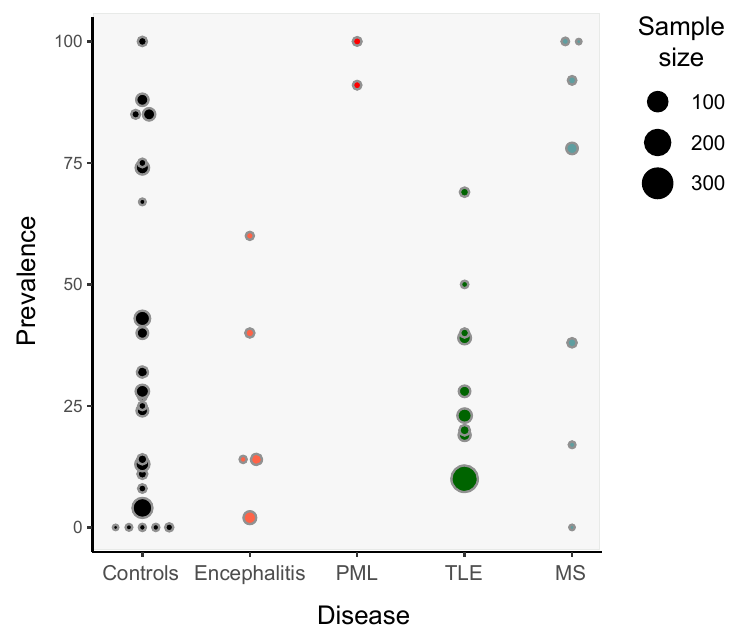
Figure 2. Dotplot indicating the prevalence of detection of HHV-6 DNA in studies with a sample size greater of at least 5 individuals in different neurological conditions and controls with no neurological conditions. The size of each dot is proportional to the sample size of each study. When multiple regions were assessed per individual, we chose the one with the highest HHV-6 prevalence.